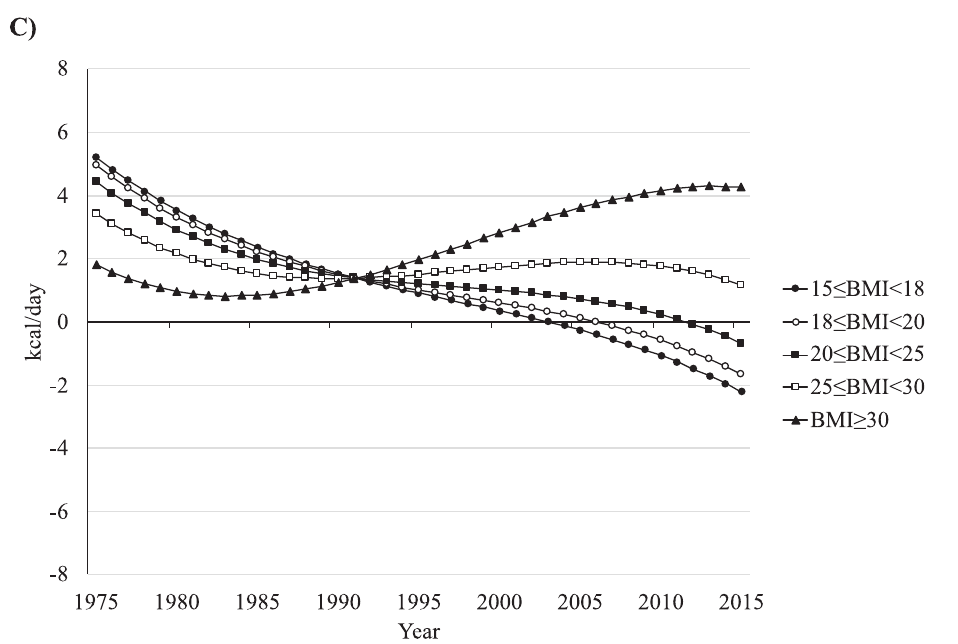
Figure 2. Estimated energy imbalance gap (kcal / day) for Japanese adults aged 20 to 74 years, 1975 to 2015, by (A) sex and by BMI class in (B) men and (C) women. BMI, body mass